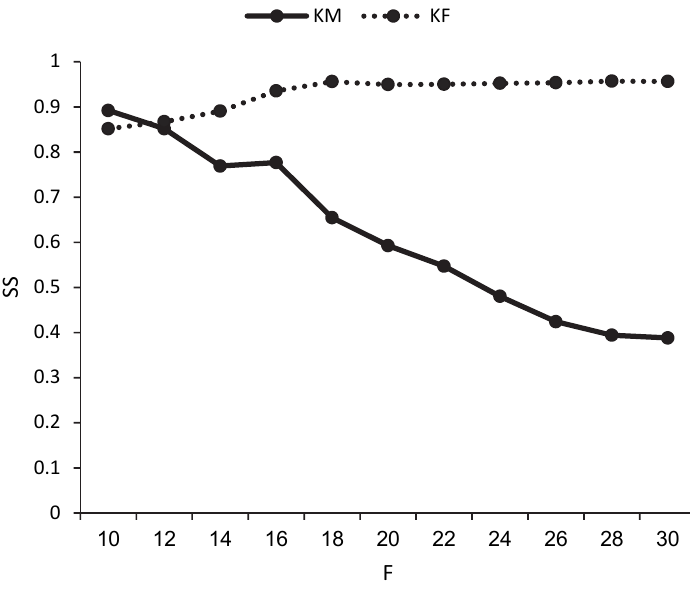
Fig. 4. The results achieved by the methods based on the SS when F